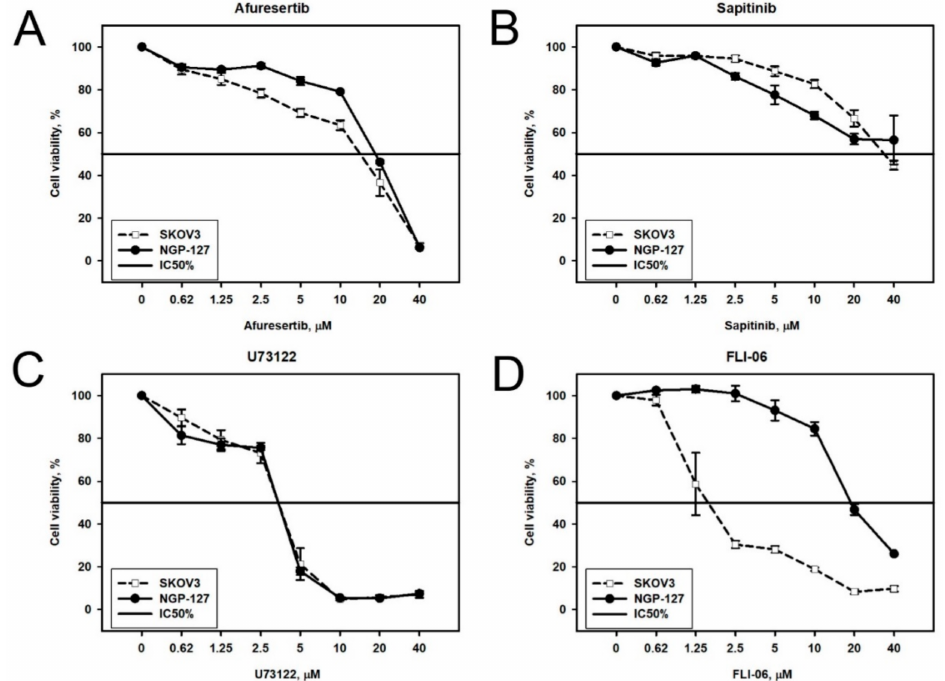
Figure 3. Viability of SKOV-3 and NGP-127 cells treated with different concentrations of target drugs: ( A ) Akt inhibitor Afuresertib; ( B ) EGFR and ErbB inhibitor Sapitinib; ( C ) phospholipase C inhibitor U73122; and ( D ) Notch inhibitor FLI-06. Viability and IC 50 were measured with MTT